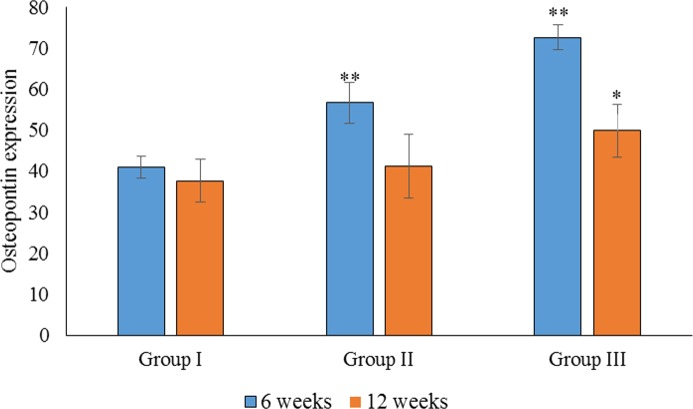
Statistical analysis of the percentage expression of osteopontin as a bone-formation marker between groups I, II and III at 6 and 12 weeks.Data are presented as the average of three independent experiments (n = 3). ∗∗Significant difference between the control (group I) and experimental groups (groups II and III). ∗Significant difference between groups III and II. A p-value of <0.05 was considered significant in all analyses.